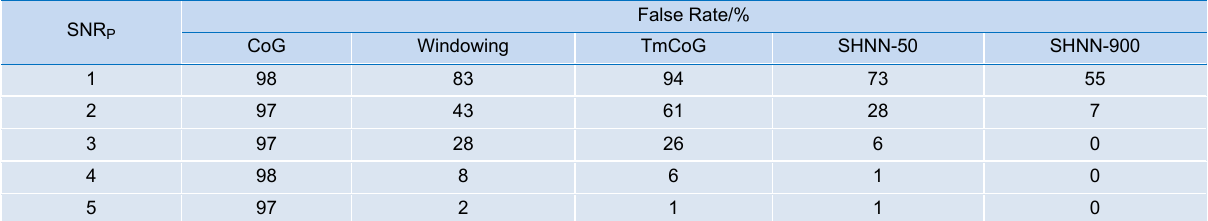
Table 1 | The false rate of different methods in low SNR situations, where CoG means Center of Gravity method and TmCoG means a modified CoG method using m % of the maximum intensity of spot as threshold. Table reproduced from ref. 73 , Optical Society of America. SNR